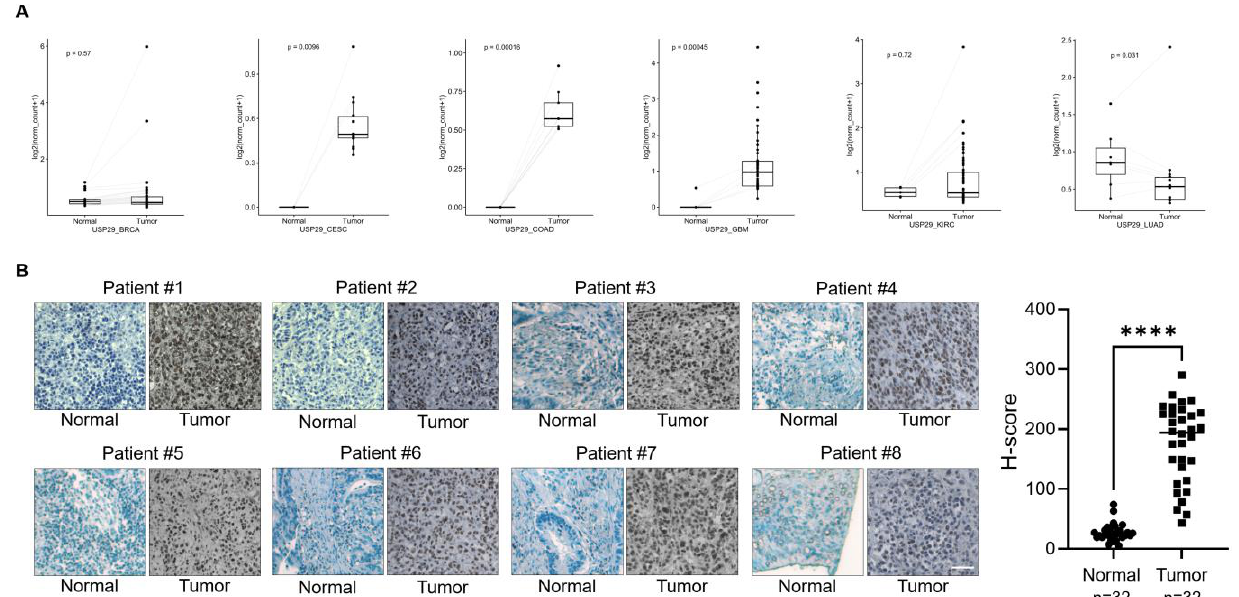
Figure 1. USP29 is upregulated in human colon cancer. ( A ) Box plot showing the expression patterns of USP29 in normal vcompared to tumor tissues of human colon cancer patients using TCGA RNAseq data. p < 0.05 is considered statistically significant. ( B ) Representative immunohistochemical staining of endogenous USP29 in human colon cancer and corre- sponding normal tissues. All IHC tissues were quantified by an H score. **** p < 0.0001 and Scale bar = 30 µm.